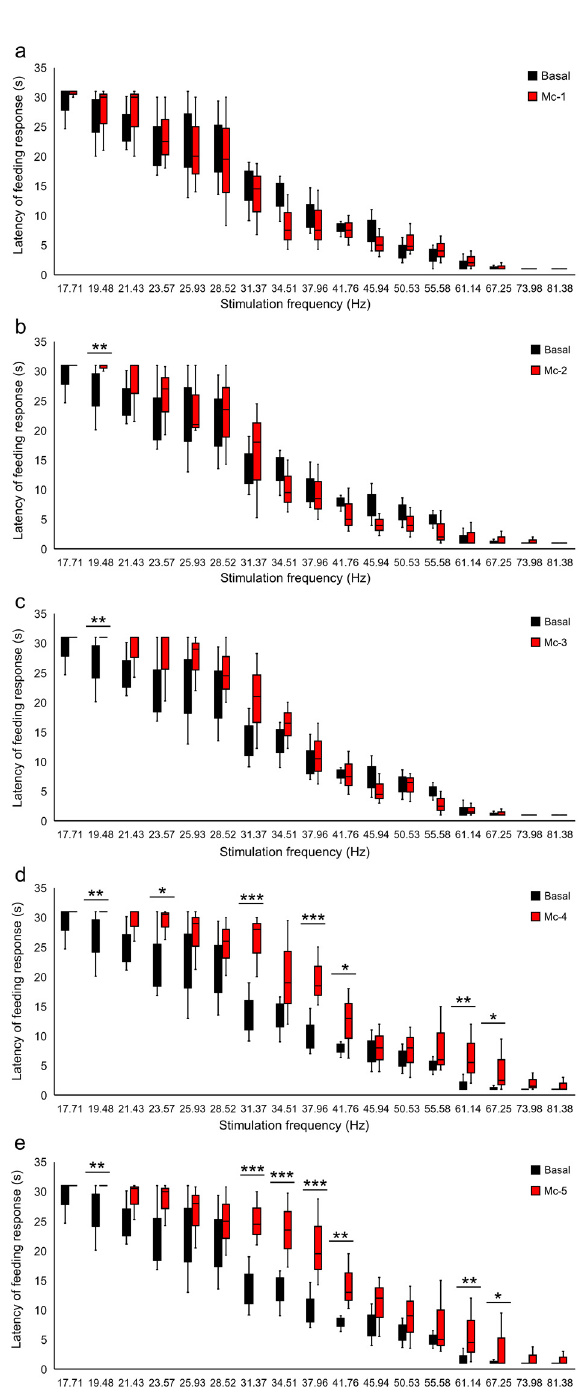
Figure 2. Destabilization of the VTA electrical stimulation (Es ‐ VTA) ‐ induced feeding response (FR) directly after morphine administration at different doses [0.25 μ g/0.5 μ L (Mc ‐ 1 group) ( a ), 0.5 μ g/0.5 μ L (Mc ‐ 2 group) ( b ), 1.0 μ g/0.5 μ L (Mc ‐ 3 group) ( c ), 1.25 μ g/0.5 μ L (Mc ‐ 4 group) ( d ), and 1.5 μ g/0.5 μ L (Mc ‐ 5 group) ( e )] injected into the PPN in the contralateral hemisphere (red ‐ filled bars) (n = 5 for each dose) compared to artificial cerebrospinal fluid injection (ACSF; 0.5 μ L) into the PPN as basal groups (black ‐ filled bars) ( a – e ). * p < 0.05, ** p < 0.01, and *** p < 0.001 (Tukey’s post hoc test) indicate significant differences in the FR latency at different frequencies of Es ‐ VTA in the Mc ‐ 1, Mc ‐ 2, Mc ‐ 3, Mc ‐ 4, and Mc ‐ 5 experimental groups compared to the basal group.